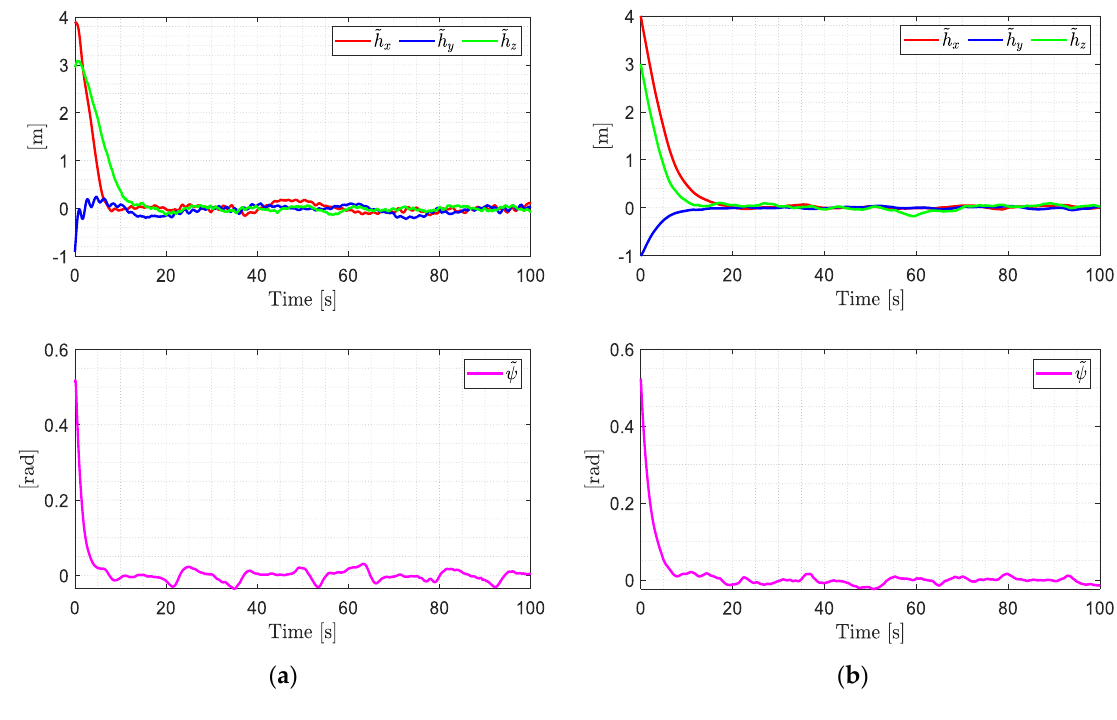
(cid:16) (cid:17) ~ = h ,h ,h h and angle errors ψ . ( a ) Real control errors; ( b ) Simulation h = and angle errors (cid:101) ψ . ( a ) Real control errors; ( b ) Simulation (cid:101) h x , (cid:101) h y , (cid:101) h z x y z